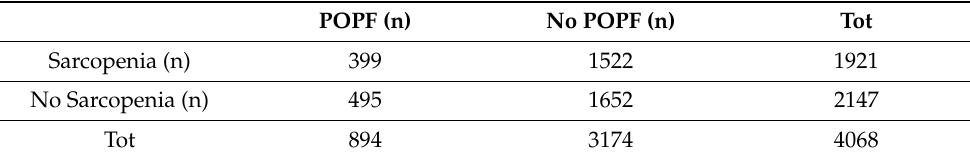
POPF: postoperative pancreatic fistula.